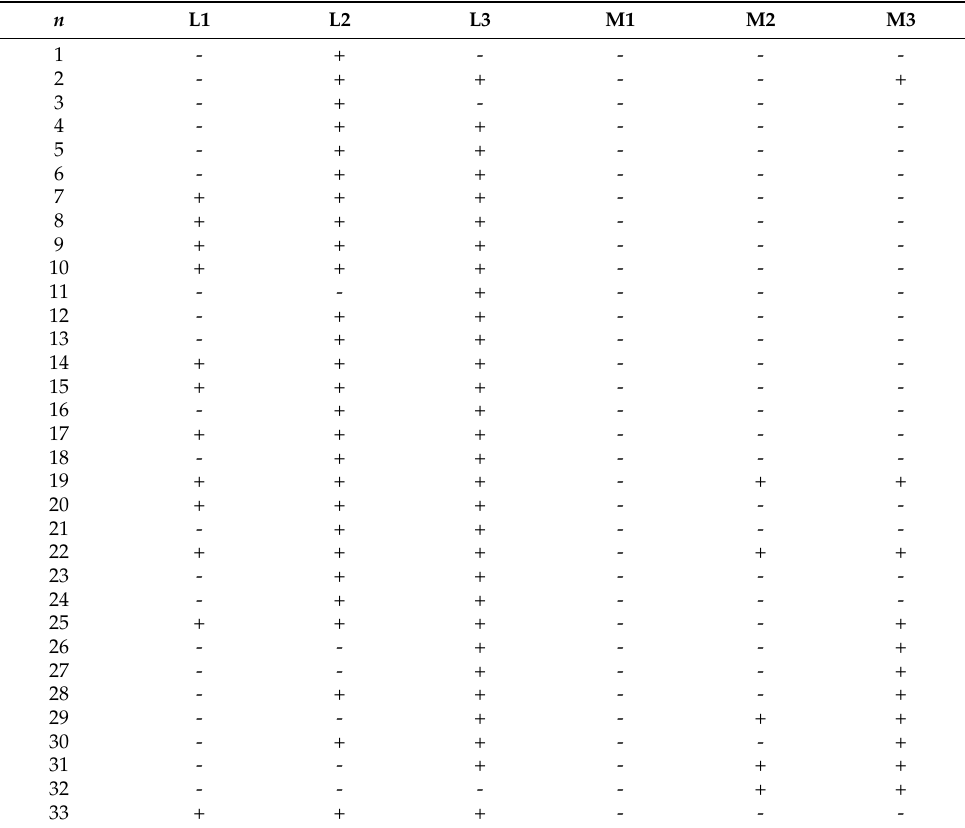
Table 1. Distribution of the numbness to the skin areas around the